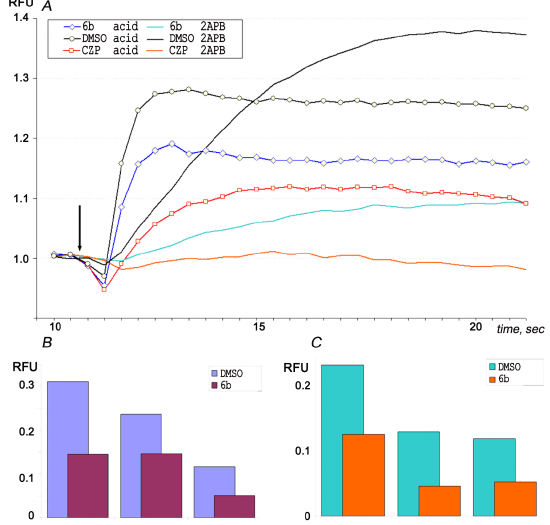
Figure 6. Intracellular Ca 2+ assay on CHO cell-expressed TRPV1 ion channel. ( A ) Channel activation at the moment indicated by arrow was performed by acidification (final pH 6.2) or by 160 μ M 2APB. Compound 6b in 50 μ M concentration, buffer (2% DMSO) or 50 μ M capsazepine (CZP) was added in the well 5 min before measurement. Three independent measurements of the ion channel